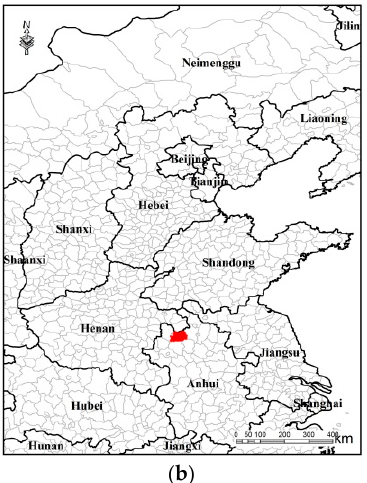
Figure 1. Guoyang County ( a ) is located in the north of Anhui province, and on the south edge of the North China Plain ( b ).